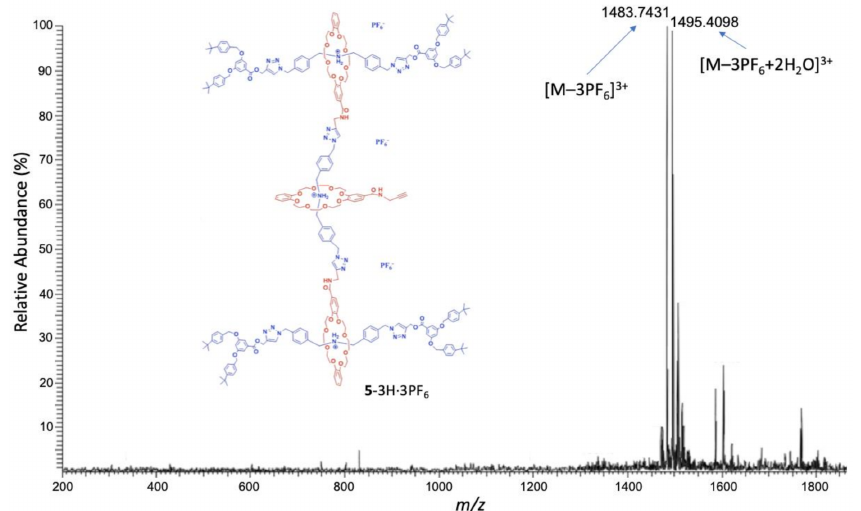
Figure 5. ESI-MS spectrum of the G2 rotaxane dendron-acetylene 5 -3H · 3PF 6 .